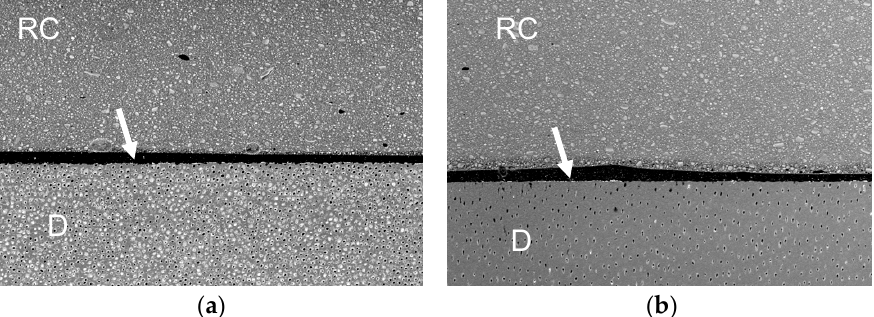
Figure 3. Backscatter SEM images of the resin–dentin adhesive interfaces of OBU after 24 h. ( a ) Re- ceived by the manufacturer; ( b ) expired. RC, resin composite. D, dentin. White arrows indicate ad- hesive layer; 250x.